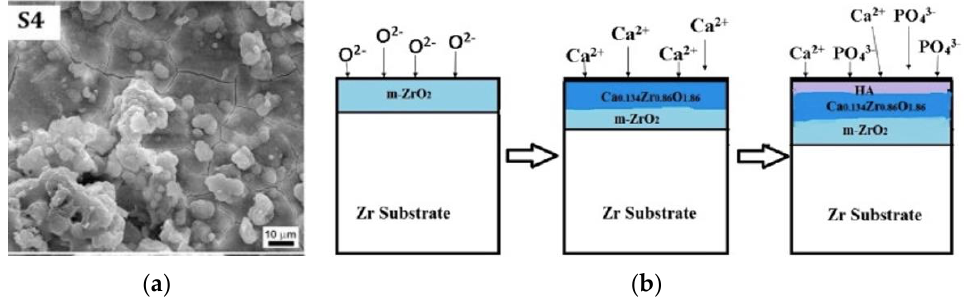
Figure 1. ( a ) SEM micrographs of the surface of the PEO coating immersed in SBF for 14 days. Formation of apatite particles is the indication of biocompatibility [24] (Reproduced with permission number: 5043530687884, Elsevier); ( b ) schematic representation of the PEO formation containing HA top layer [29] (Reproduced with permission number: 5061321012937, Elsevier).